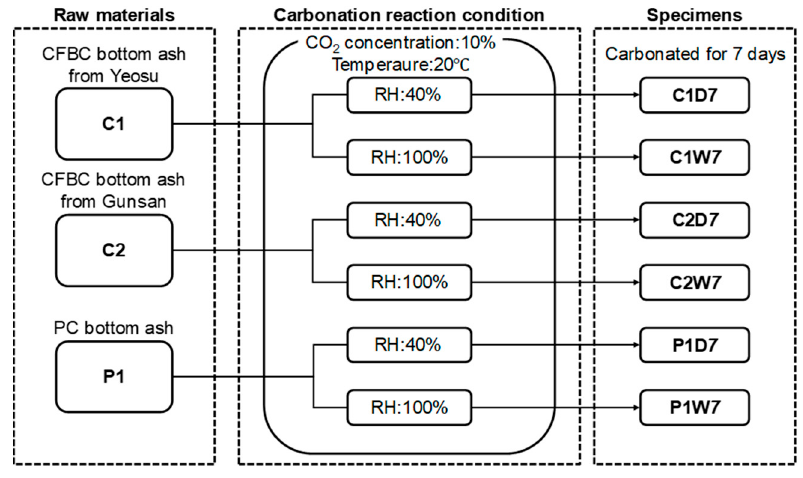
Figure 1. Carbonation conditions and nomenclatures of the samples.